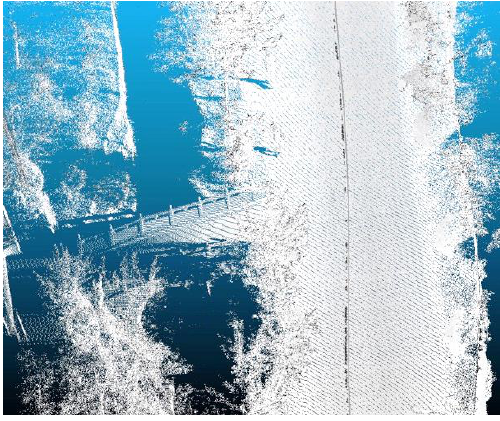
Figure 10. Obscure road